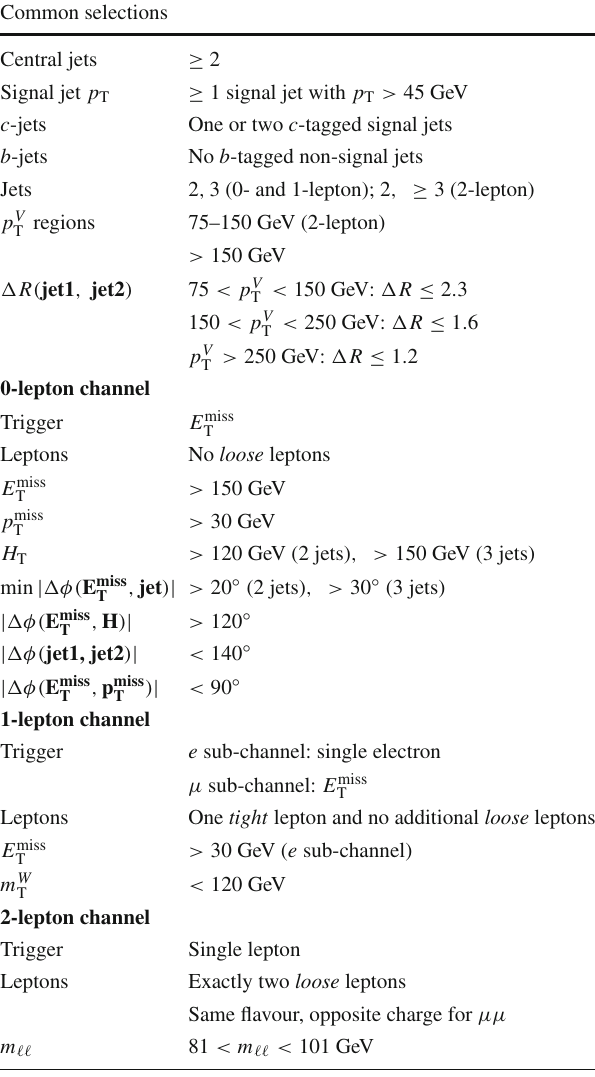
Table 2 Summary of the signal region event selection in the 0-, 1- and 2-lepton channels. Jet1 and jet2 refer to the two signal jets and H refers to the jet1–jet2